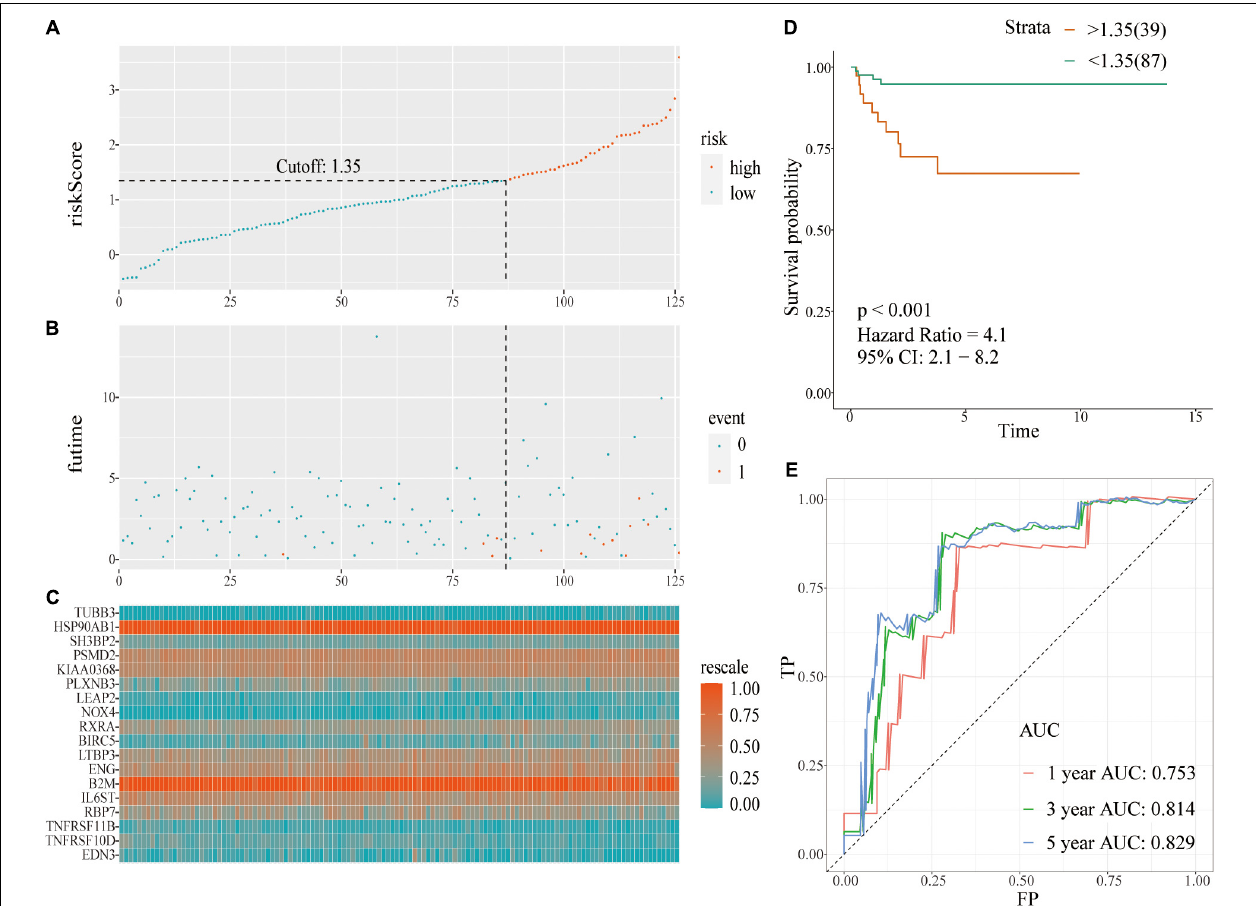
FIGURE 4 | A prognostic signature based on IRGs in the TCGA-testing set. (A) Risk score distribution based on IRGs in PCa; (B) Recurrence status of patients in different groups; (C) Heatmap showing the expression profiles of IRGs; (D) Survival analysis for the signature-defined risk groups; (E) Time-dependent ROC curve of the 18-IRGs prognostic